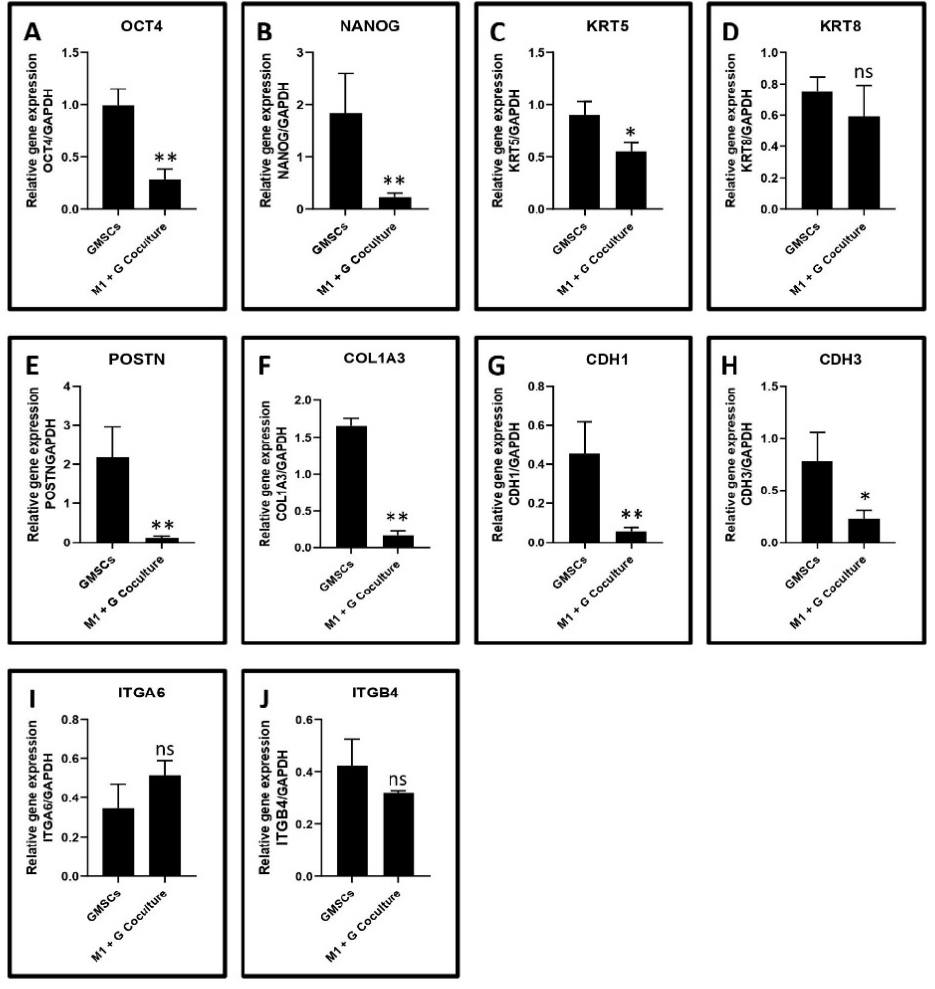
Figure 7. Bar diagrams depicting ( A )—OCT4 (** p < 0.0001), ( B )—NANOG (** p < 0.0001), ( C )—KRT5 (** p < 0.0001), ( D )—KRT8 ( p = 0.1599), ( E )—POSTN (** p < 0.0001), ( F )—COL1A3 (** p < 0.0001), ( G )—CDH1 (** p < 0.0001), ( H )—CDH3 (* p = 0.0150), ( I )—ITGA6 ( p = 0.0517), ( J )—ITGB4 ( p = 0.0995) gene expression in gingival stem cells and heterogeneous cell populations versus the gingival stem cells and heterogeneous cells co-cultured with macrophages. ns not significant.